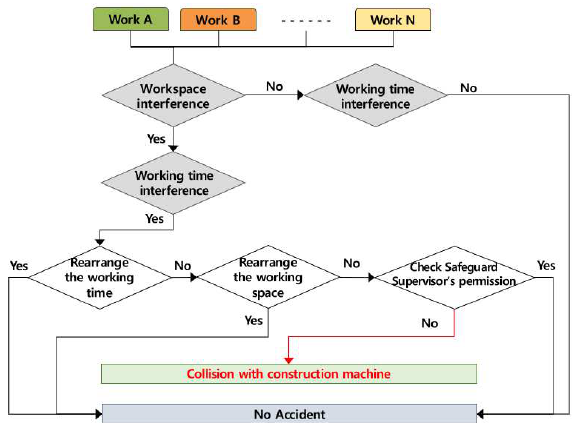
Figure 6. Mechanism of collision by multiple processes in the workplace (AMMP model for collision).